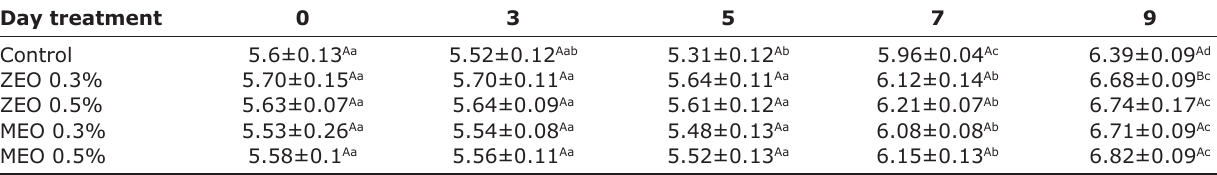
Table-2: pH values of minced beef containing different levels of ZEO and MEOs for 9 days of storage at 7°C. Day treatment